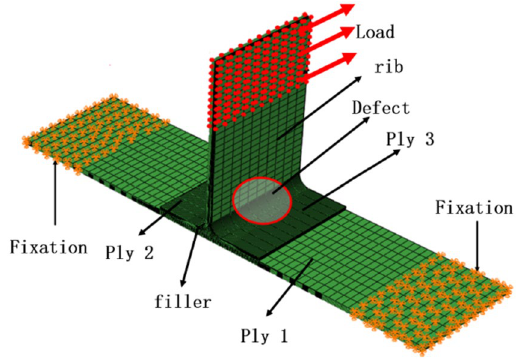
Figure 4. (Lateral bending & Shear) Finite element model (ABAQUS 6.14, https:// www. 3ds. com/ produ cts- servi ces/ simul ia/ produ cts/ abaqus) 43 .